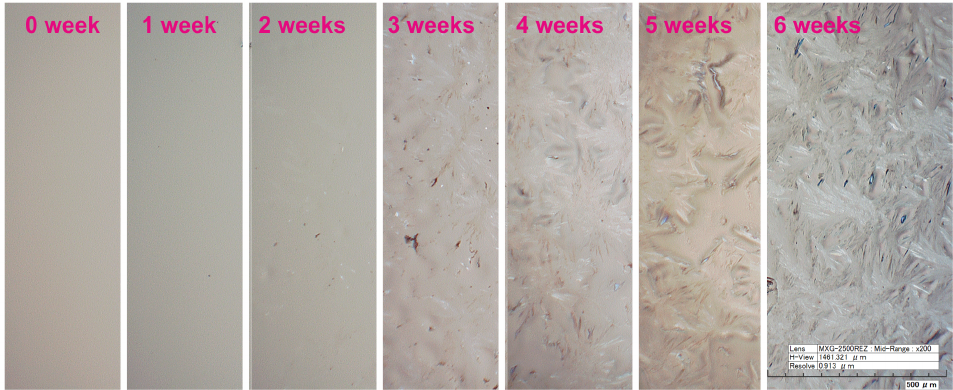
Figure 1. Digital microscope depiction of progressing surface degradation.